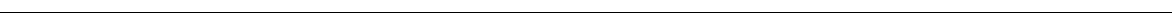
Fig. 4 Ductal-neuroendocrine plasticity contributes to gemcitabine resistance. a SYP mRNA (left panel) and SYP protein (right panel) expression in human PDA cell lines. Fold change in SYP mRNA expression was determined by qRT-PCR (normalized to TBP) relative to the immortalized duct epithelial cell line hTERT-HPNE (HPNE). Fold change in SYP protein expression (normalized to GAPDH) relative to HPNE was determined by Western blot. P values indicate signi fi cance when comparing to HPNE. Results representative of n = 3 experimental replicates. b Cells were treated with the indicated doses of gemcitabine and measured using MTS assay. Results represent average of n = 3 experimental replicates. c Cells were treated with gemcitabine for the indicated time points and neuroendocrine genes were assessed by qRT PCR (normalized to TBP ). P values indicate signi fi cance when comparing each single gene to the zero hour time point. Results representative of n = 3 experimental replicates. d MiaPaca2 and Capan1 cells were treated with gemcitabine for 72 h, fi xed and stained for SYP by IF. The percentage of SYP positive cells of total DAPI positive cells was quanti fi ed for triplicate wells, 3 images/well. Representative images and quantitation from three experimental replicates are shown. Scale bars indicate 20 µ M. e Western analysis of tumor lysates from subcutaneous (SubQ) PDX tumors treated with vehicle or gemcitabine. SYP expression relative to GAPDH was quanti fi ed for each tumor. f HPAFII cells were treated with PBS or gemcitabine ( n = 3 experimental replicates) and RNA sequencing was performed. Fold change in neuroendocrine genes, neuronal genes, and genes involved in vesicle traf fi cking for gemcitabine treated vs. PBS cells are shown. For all panels, error bars indicate standard deviation and * P < 0.05, ** P <